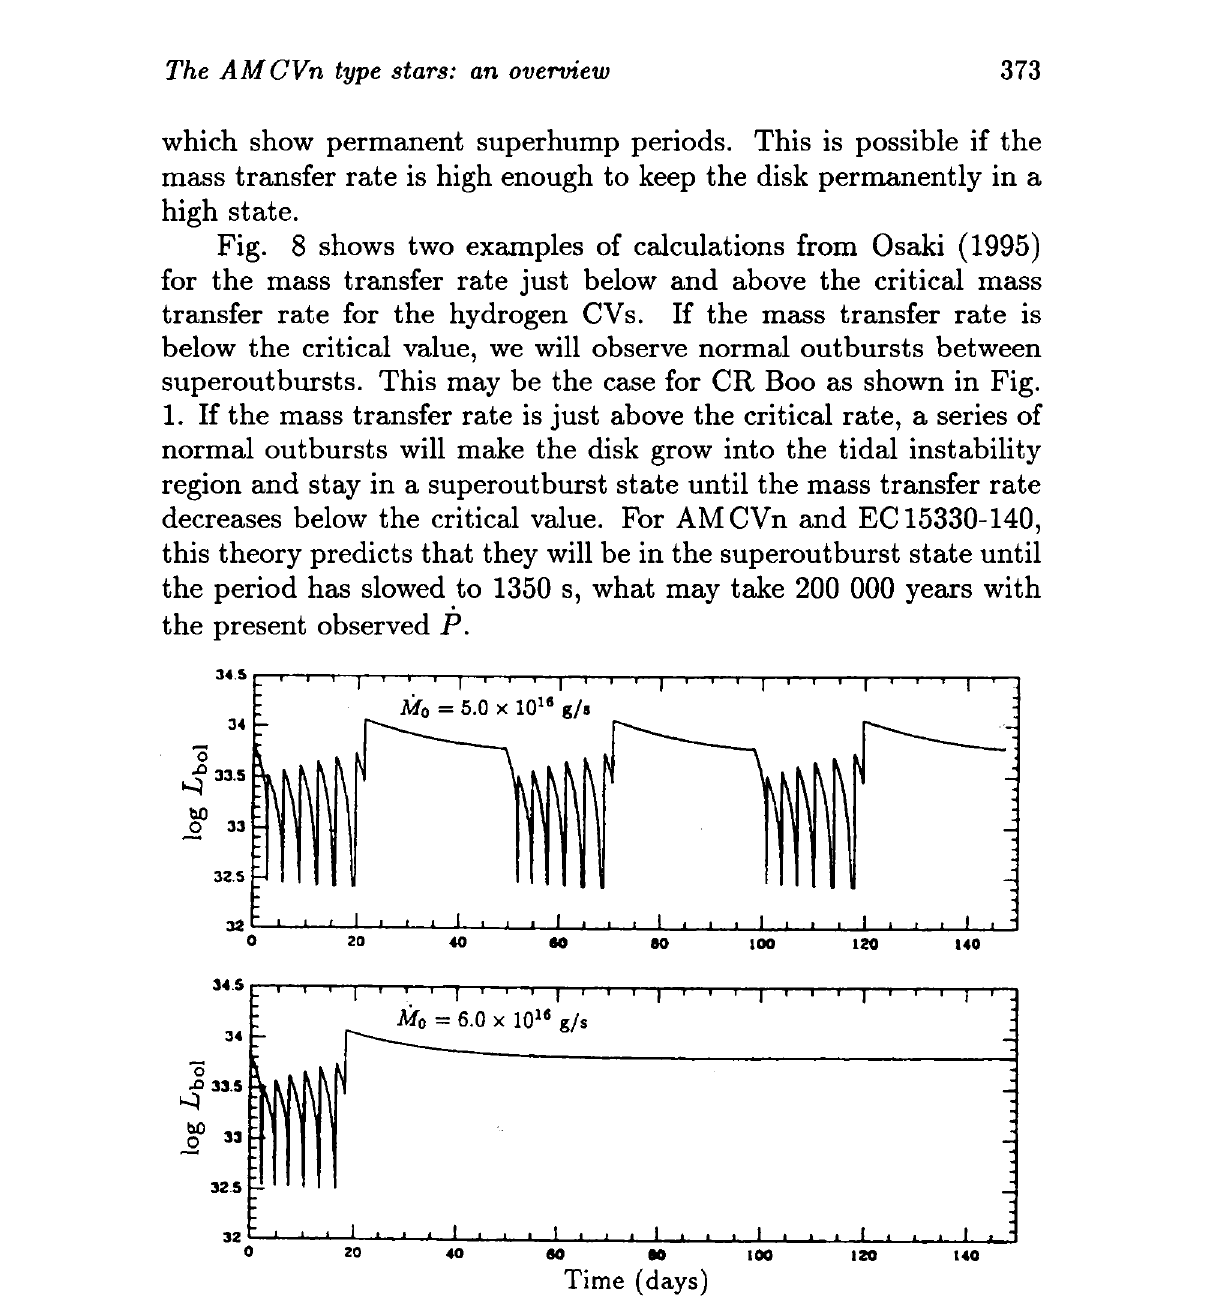
Fig. 8. Bolometric light curves for a mass transferring system with the mass transfer rate just below the critical rate (upper panel) and for a system which is transferring mass at the critical rate (lower panel) (from Osaki 1995). When the critical mass transfer rate is reached, the light curve shows a permanent high